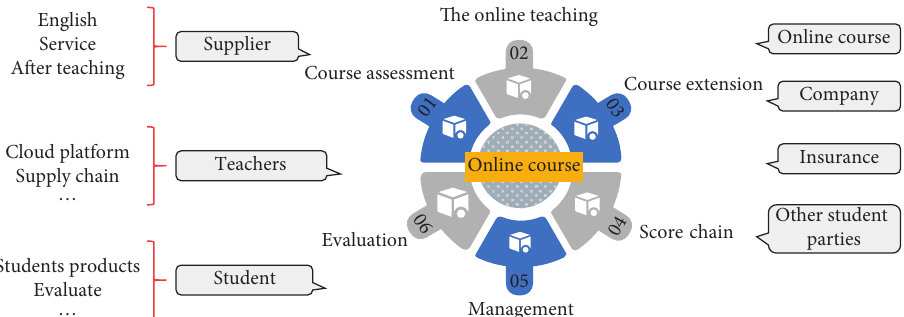
Figure 1: Research directions in online